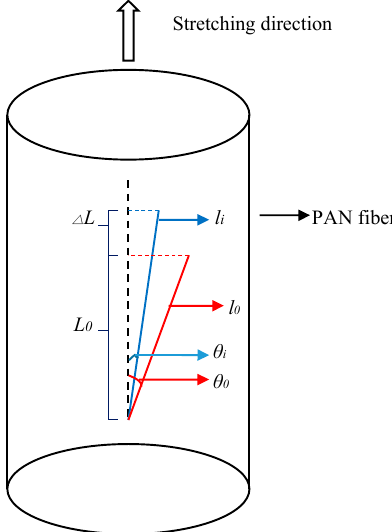
Figure 8. Schematic diagram of the deformation behavior of the PAN chain during hot stretching.